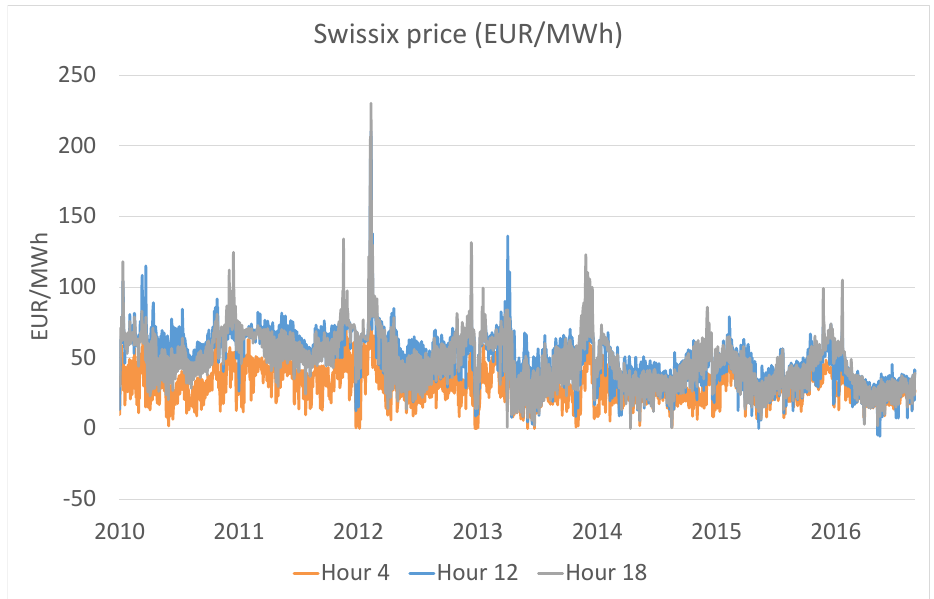
Figure 3. Actual supply and demand functions from the German/Austrian ( top ) and the Swiss ( bottom ) market for hour 11:00 a.m.–12:00 p.m. on 31 August 2016 as observed on the European Power Exchange (EPEX).